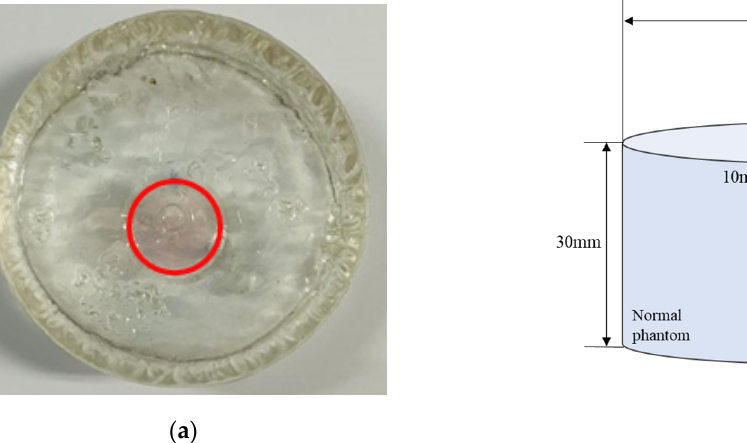
Figure 2. ( a ) Photograph of phantom (red line: tumor phantom boundary); ( b ) geometry of phantom and location of inserted thermocouples.